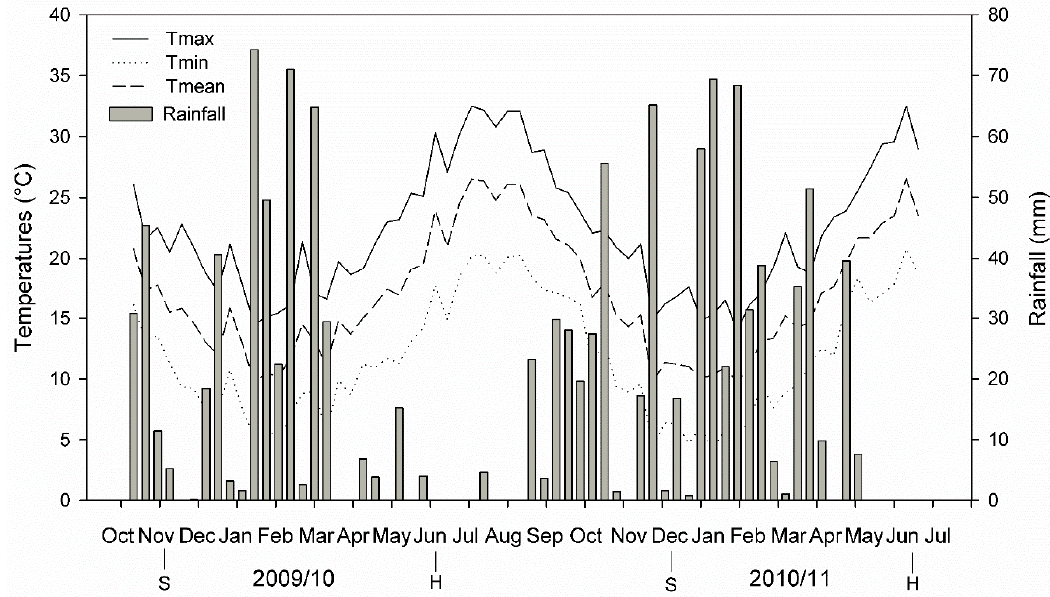
Figure 1. Meteorological time course from sowing (S) to harvest (H) of durum wheat genotypes in two growing seasons (2009/10 and 2010/11) at the experimental site (Catania, 37°24 ′ N., 15°03 ′ E., 10 m a.s.l.).